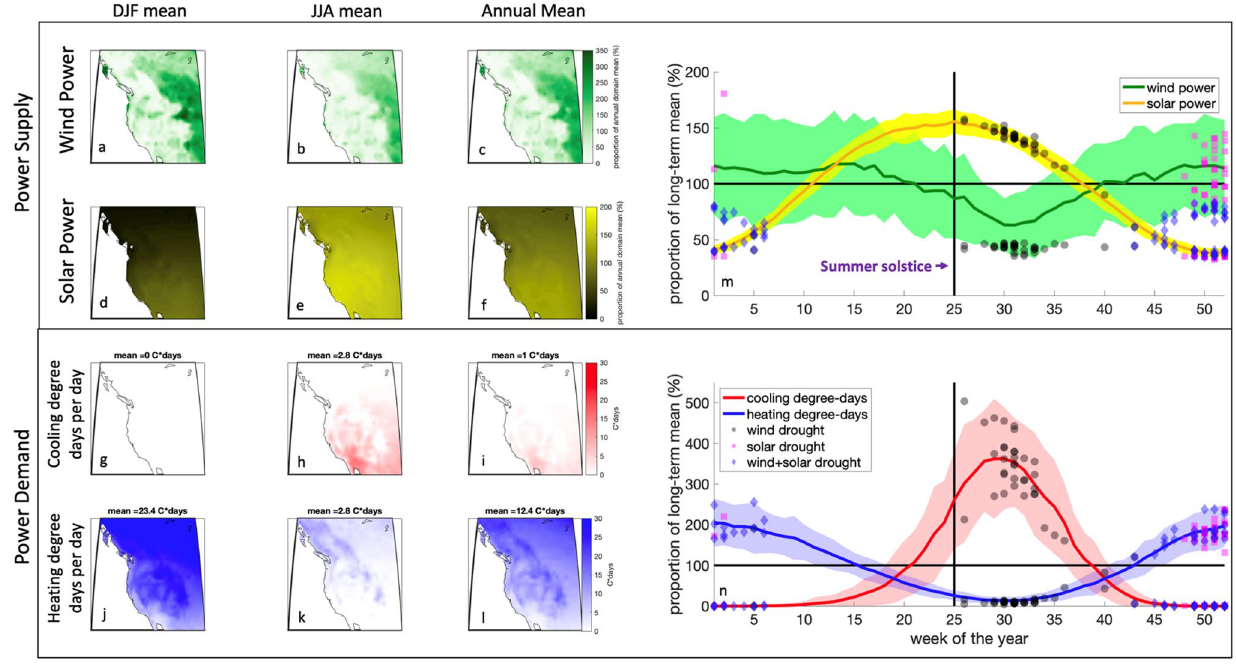
wind and solar resource are expressed as a proportion of the long term domain mean to emphasize the spatial distribution of the resource rather than the absolute value which depends on tech- nological assumptions. Right) temporal distribution of climatology with 1st percentile drought weeks